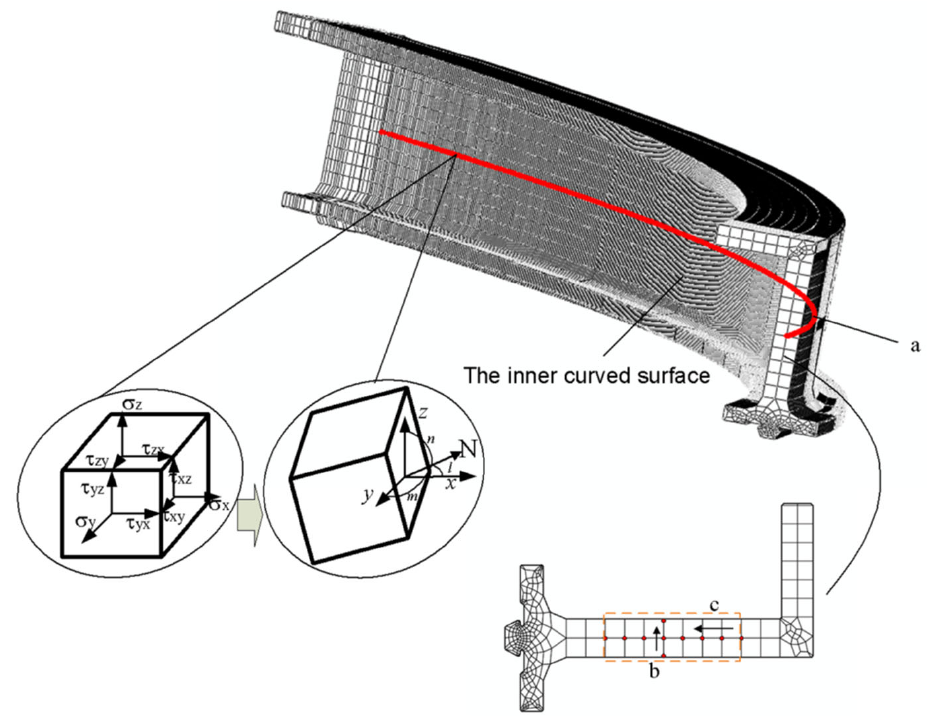
Figure 7. The calculation of axial normal stress, the profile measurement area and measurement paths.